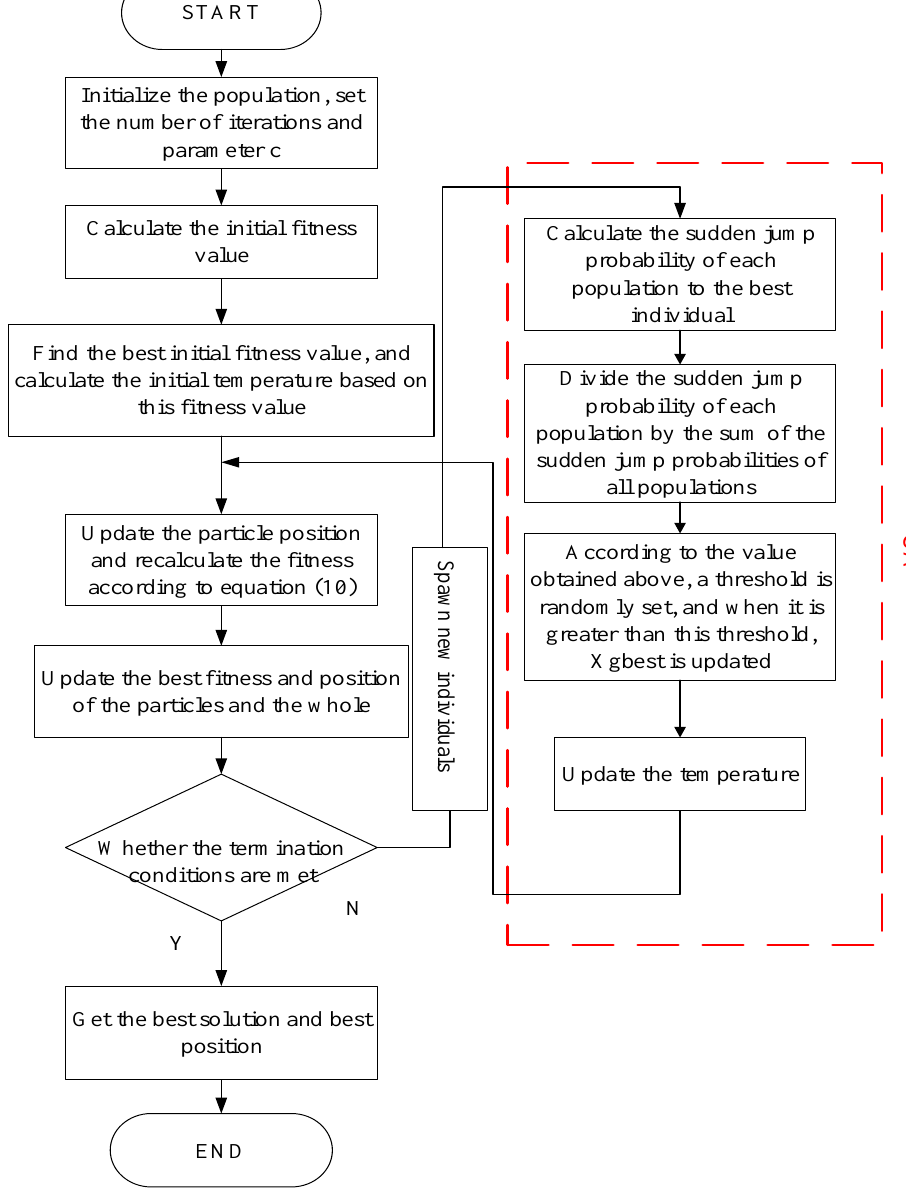
Figure 3. Flow chart of SA-QUATRE algorithm.